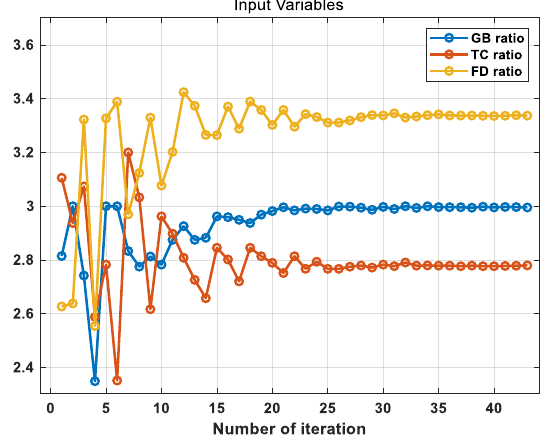
Figure 13. Optimization results for the GB, FD and TC ratios. Tables 4 and 8 show the optimized parameter values and fuel consumption results for all cases, respectively. The fuel consumption is 3.493 L/100 km for combined cycle, which is an improvement compared to 3.527 L/100 km for the non-sized case. The opti- mized values are 2.995, 3.337 and 2.780 for the GB, TC and FD ratios, respectively. In this study, the fuel consumption results for three gear ratios of a power-split hy- brid vehicle were minimized using the proposed sizing algorithm. Table 8. Component-sizing results and acceleration performance for Case 4.